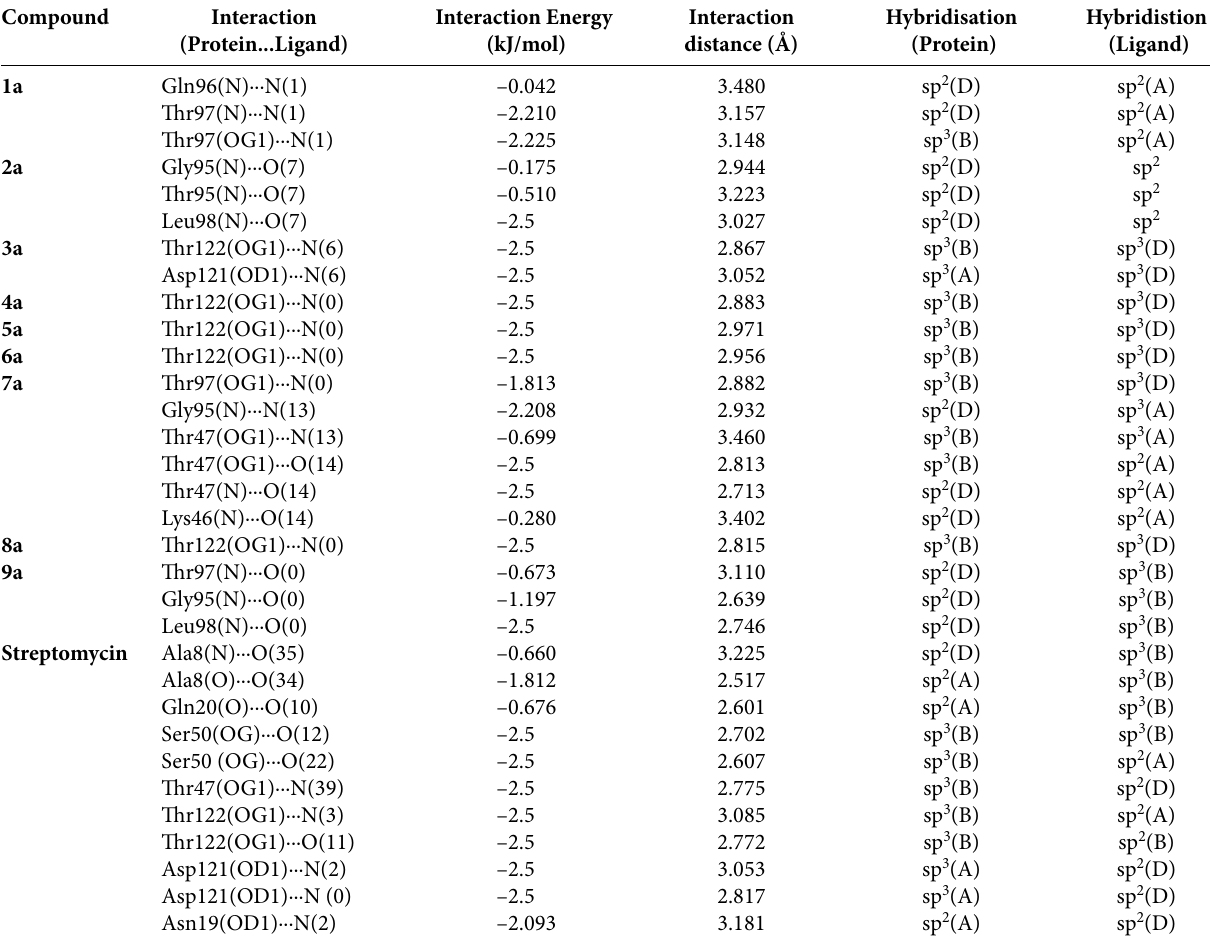
Table 7. Molecular interaction analysis of the compounds with the active site of 3SRW